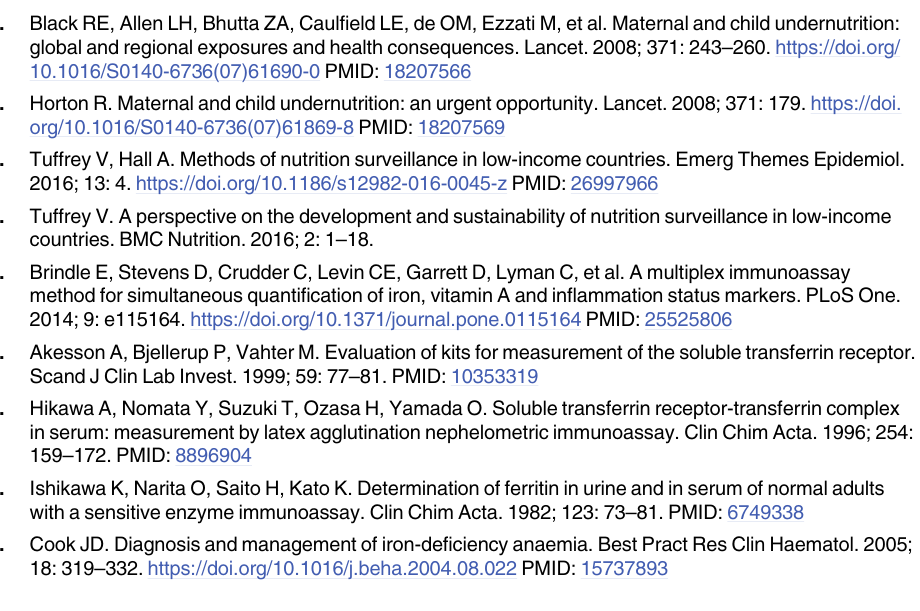
S2 Table. Performance comparison of different sTfR assays on both panels from USA donors and NiMaNu. Median concentrations and interquartile range (IQR) of sTfR as mea- sured by three immunoassay methods per sample set and comparisons between assays in abso- lute value (% recovery) and by Spearman